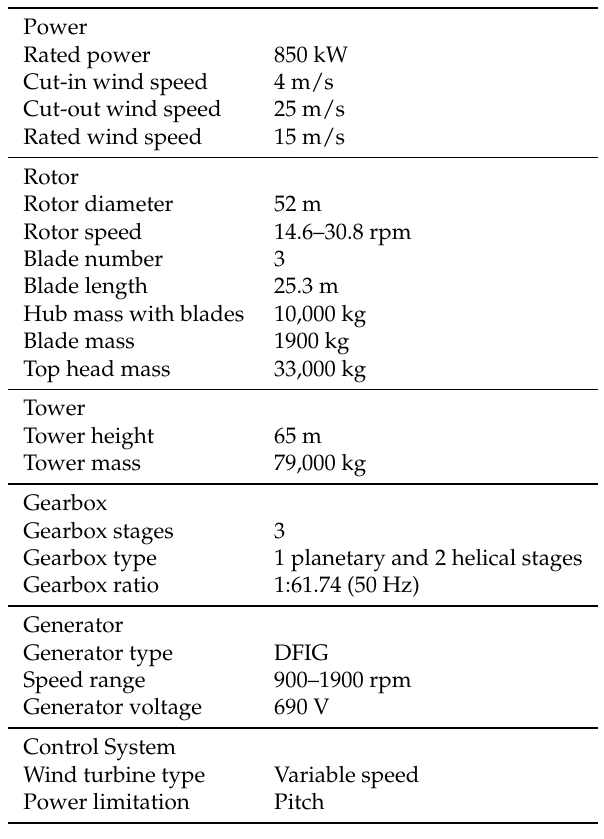
Table 2. Gamesa G52 WT technical